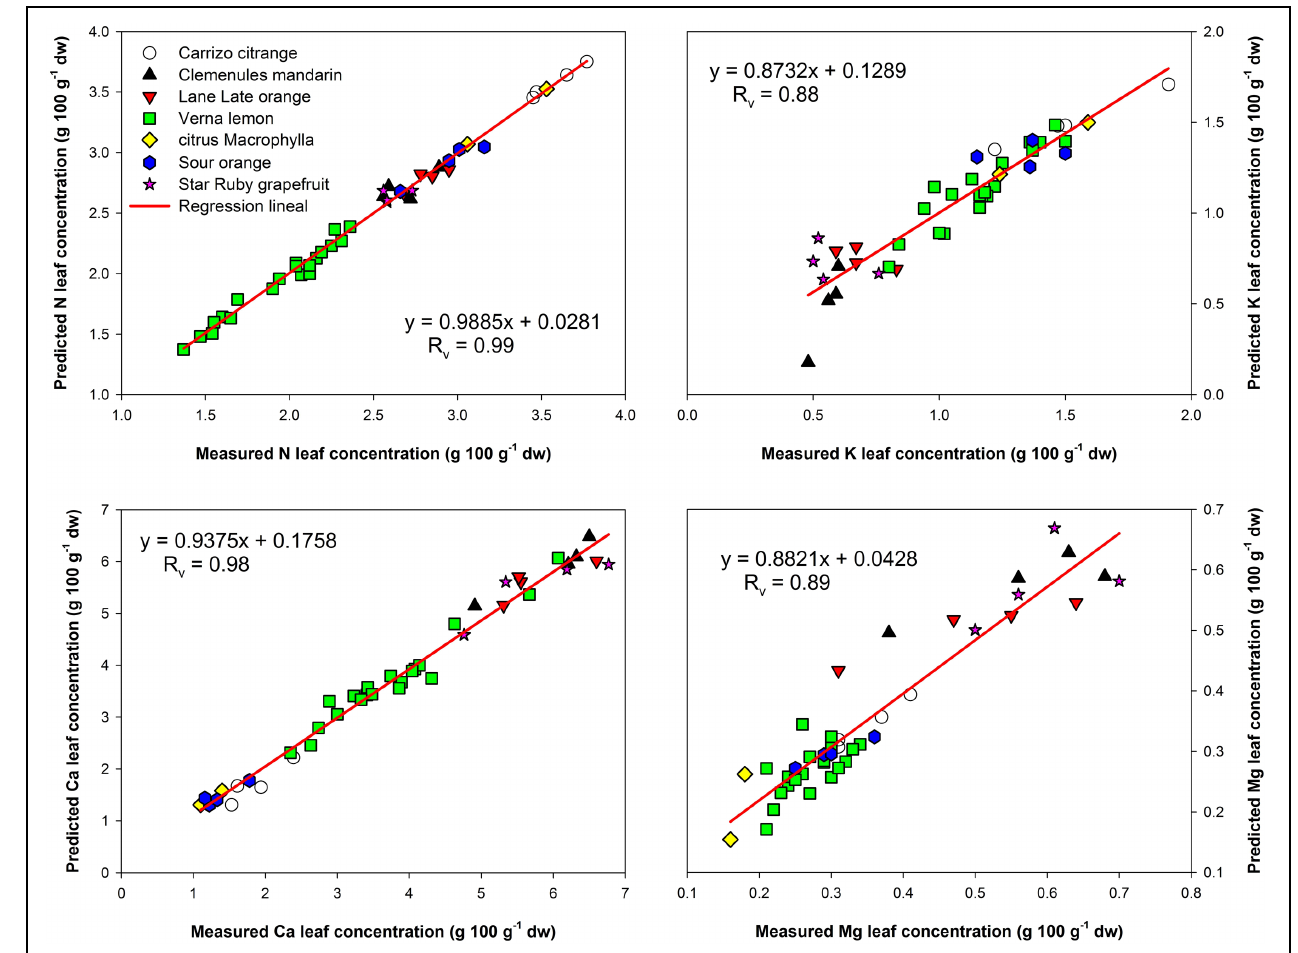
FIGURE 2 | Near infrared reflectance spectroscopy validation plots between predicted and measured values for N, K, Ca, and